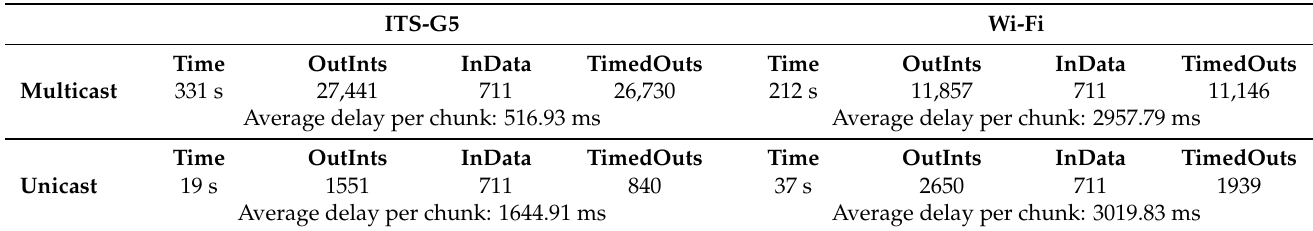
Table 5. Pipelined results—full 6 MB file using both ITS-G5 and Wi-Fi (3 MB to each interface). ITS-G5